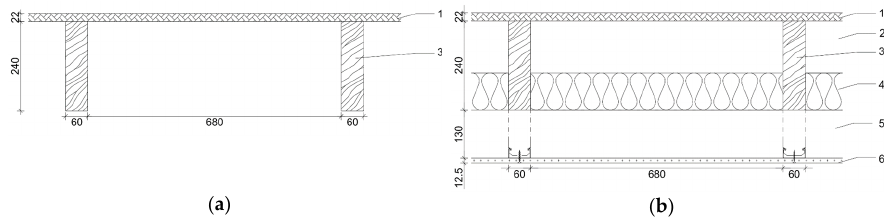
Figure 1. Cross-sections of model 1a ( a ) and 1b ( b ) of the wooden frame floor. 1–OSB board, 2–air gap, 3–wooden joints, 4–mineral wool ρ = 12 kg/m 3 , 5–air gap, 6–plaster board.